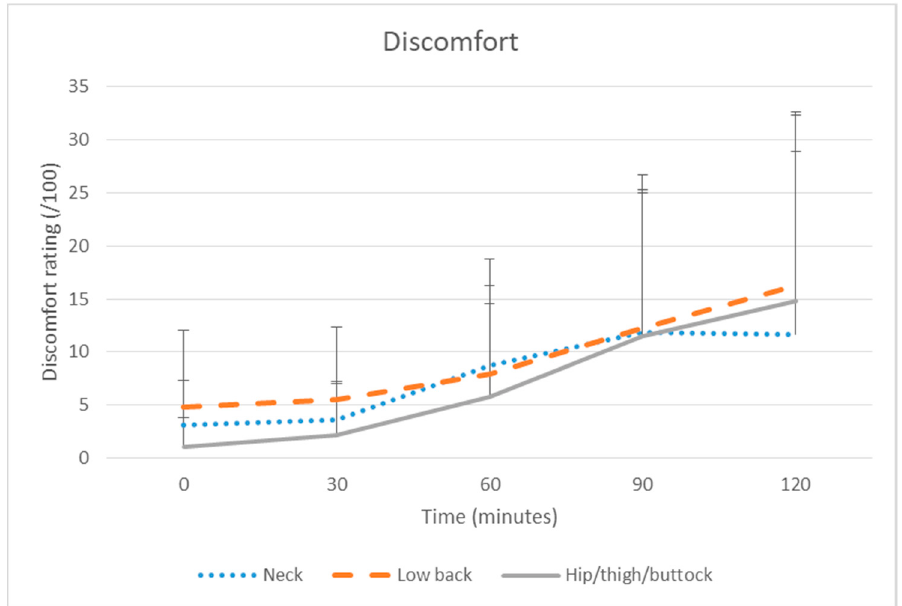
Figure 2. Discomfort (mean + standard error) for neck, low back and hip/thigh/buttock over two hours prolonged sitting (non transformed data). Table 2. Cognitive function [mean (standard deviation)] over 2 h of prolonged sitting with coefficient (Beta) for effect of time.